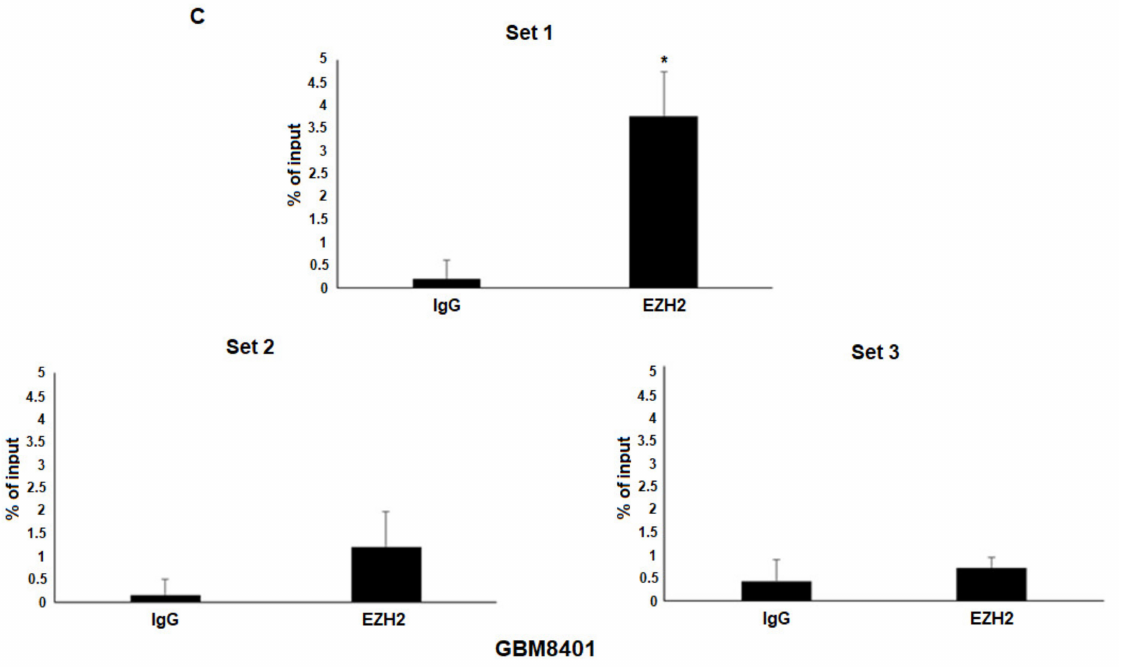
Figure 4. EZH2 represses miR-9 expression. ( A ) Expression of miR-9 in U87-MG, GBM8401, and DBTRG-05MG EZH2 overexpression / knockdown cells was evaluated using qRT-PCR. ( B ) Schematic representation of the miR-9 locus, transcripts, CpG islands, and histone modification (EZH2), which was downloaded and modified from the UCSC Genome Browser. The box frames the genomic section of miR-9 expanded below. Numbered arrows indicated the genomic regions analyzed for EZH2 binding by ChIP assays. ( C ) Chromatin obtained from GBM8401 cells was immunoprecipitated using antibodies for EZH2 or IgG (as a control). Immunoprecipitated DNA was analyzed by PCR using specific primer sets shown in Figure 4b. Mean ± SD, n = 3. * p < 0.05; ** p <